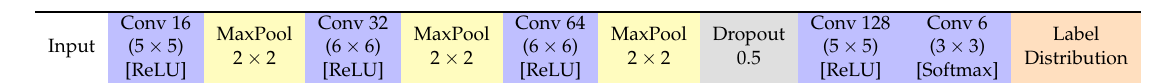
Table 3. A-ConvNet Architecture.